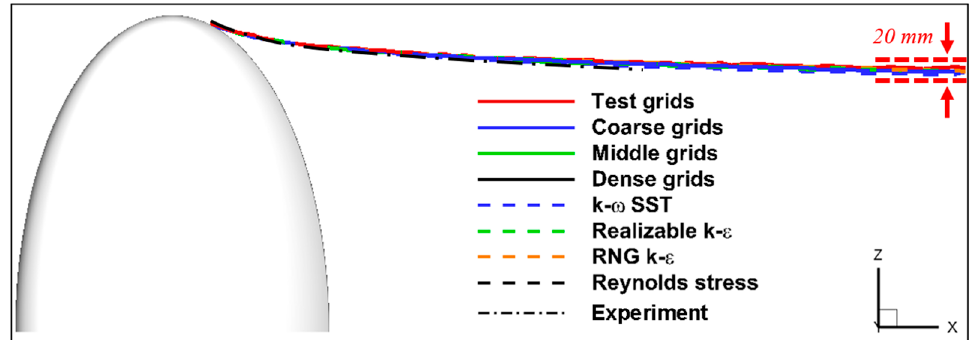
Figure 15. Vortex core trajectories predicted using different grids and turbulence models and the camera-recorded vortex core curve. Grids types are varied with the Reynolds stress model, and the turbulence models are varied with the coarse grid.